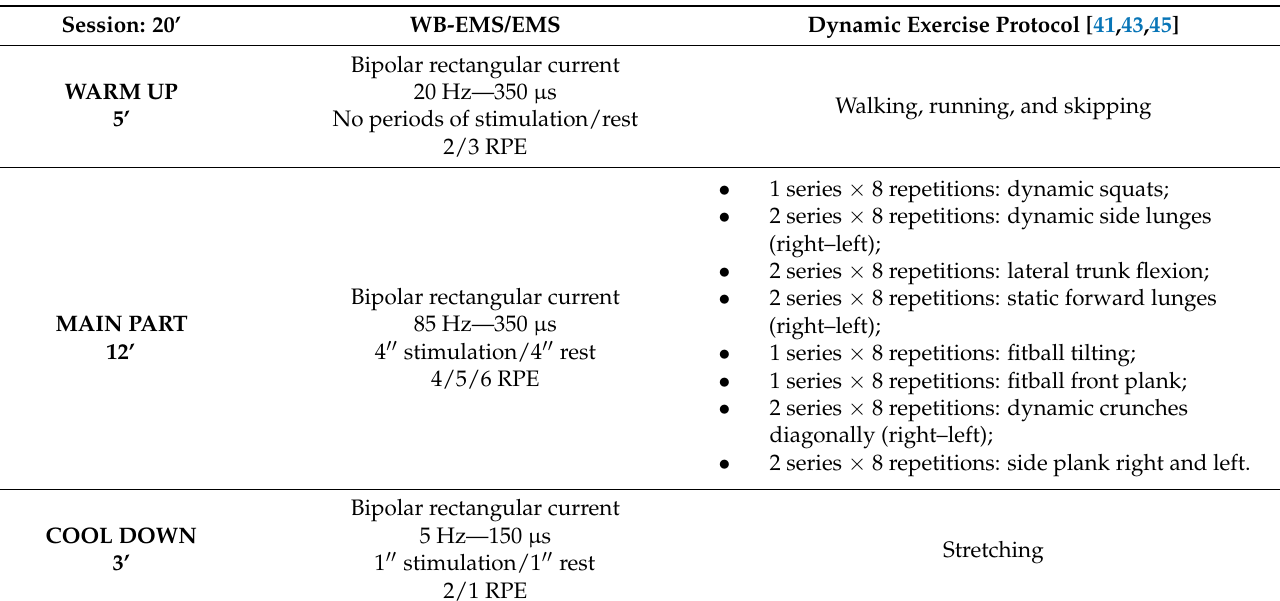
Table 1. Dynamic EMS session protocol (electrical stimulation parameters)